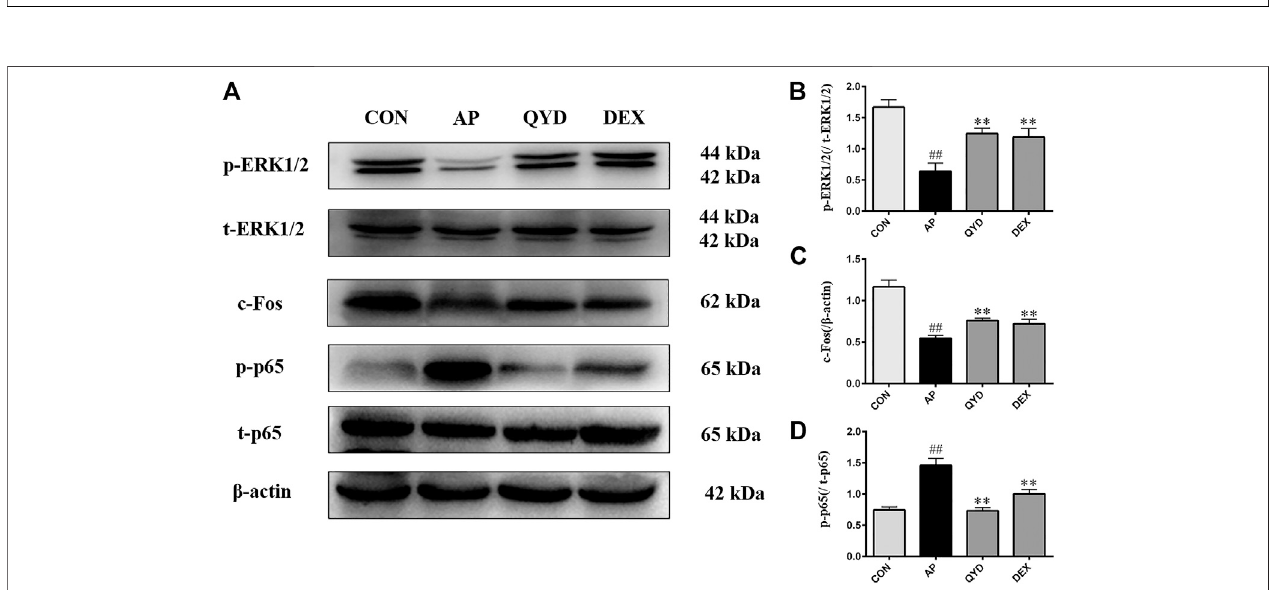
FIGURE7| QYDextractsprotectpancreastissueofSDratsbyregulatedin fl ammation andcellapoptosis. (A) EffectsofQYDextractsonp-p65,t-p65,p-ERK1/2, t-ERK1/2,c-Fos protein levels in STC-induced acute pancreatitis model basedon thewesternblottingassay; (B – D) Statistical analysisofthe effects ofQYD extracts on protein expressions levels. Data are presented as the mean ± SD ( n (cid:2) 3), ** p < 0.01 vs. AP group. ## p < 0.01 vs. CON group.